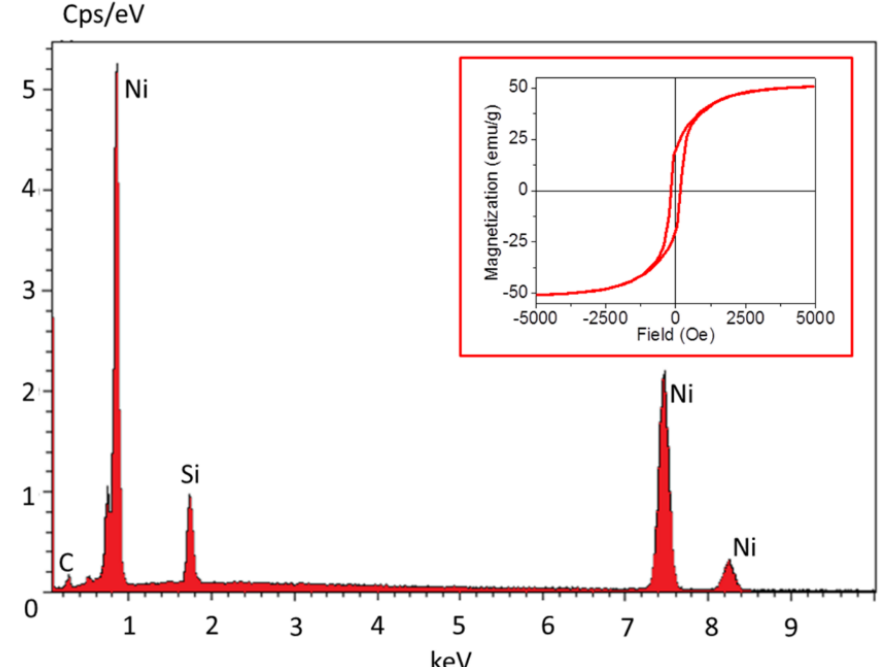
Figure 5. The typical energy-dispersive X-ray spectroscopy (EDS) spectrum. The inset is hysteretic loop at room temperature of typical NiNWs. These characterizations were conducted on the product synthesized with typical process.